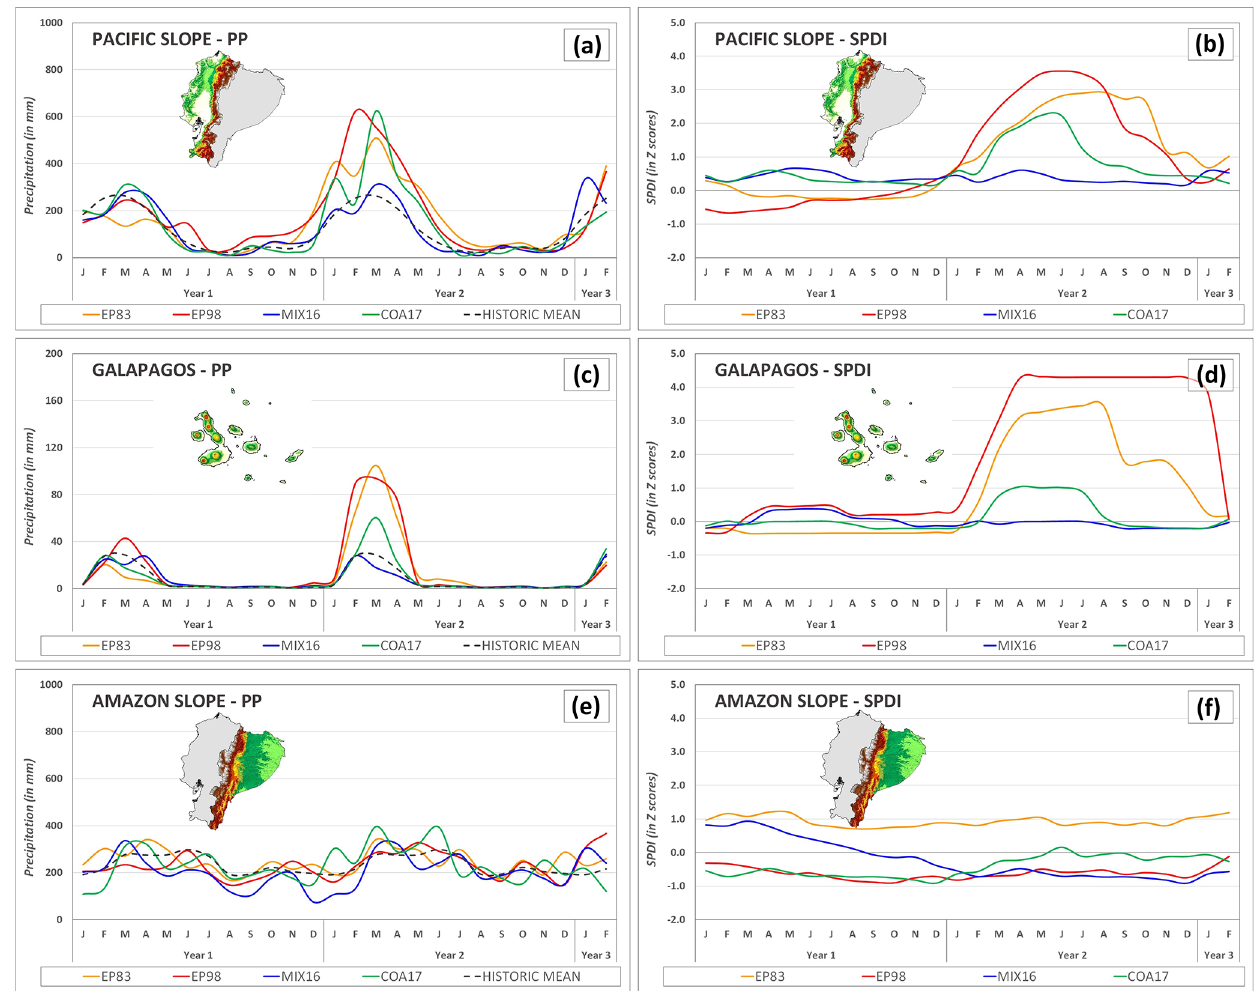
Figure 2. (a) The mean monthly precipitation (in mm) for the main study zones (the Pacific slope, Galapagos, and Amazon slope, corre- spondingly) for each extreme El Niño event (EP83, EP98, MIX16, and COA17) and Year 1 and Year 2. (b) The resulting mean Standardized Pluviometric Drought Index – SPDI (in Z scores) for each extreme El Niño event (EP83, EP98, MIX16, and COA17) and Year 1 and Year 2.